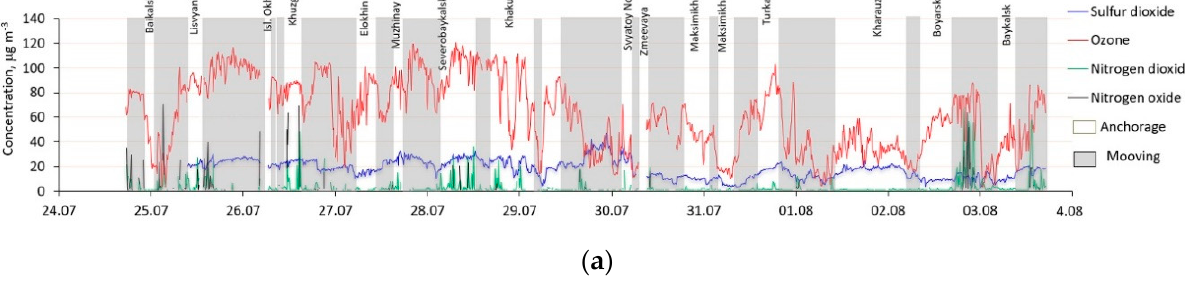
( b ) Figure 3. The plot of CALIPSO aerosol vertical profile. The X axis – latitude and longitude, the Y axis - altitude, the colors scale – type of aerosol. ( a ) aerosol subtype, UTC: 2019-07-13; ( b ) aerosol subtype, UTC: 2019-08-08. Figure 4 shows the experimental data on the spatial–temporal distribution of the concentration of ozone, sulfur dioxide, nitrogen oxides, meteorological parameters